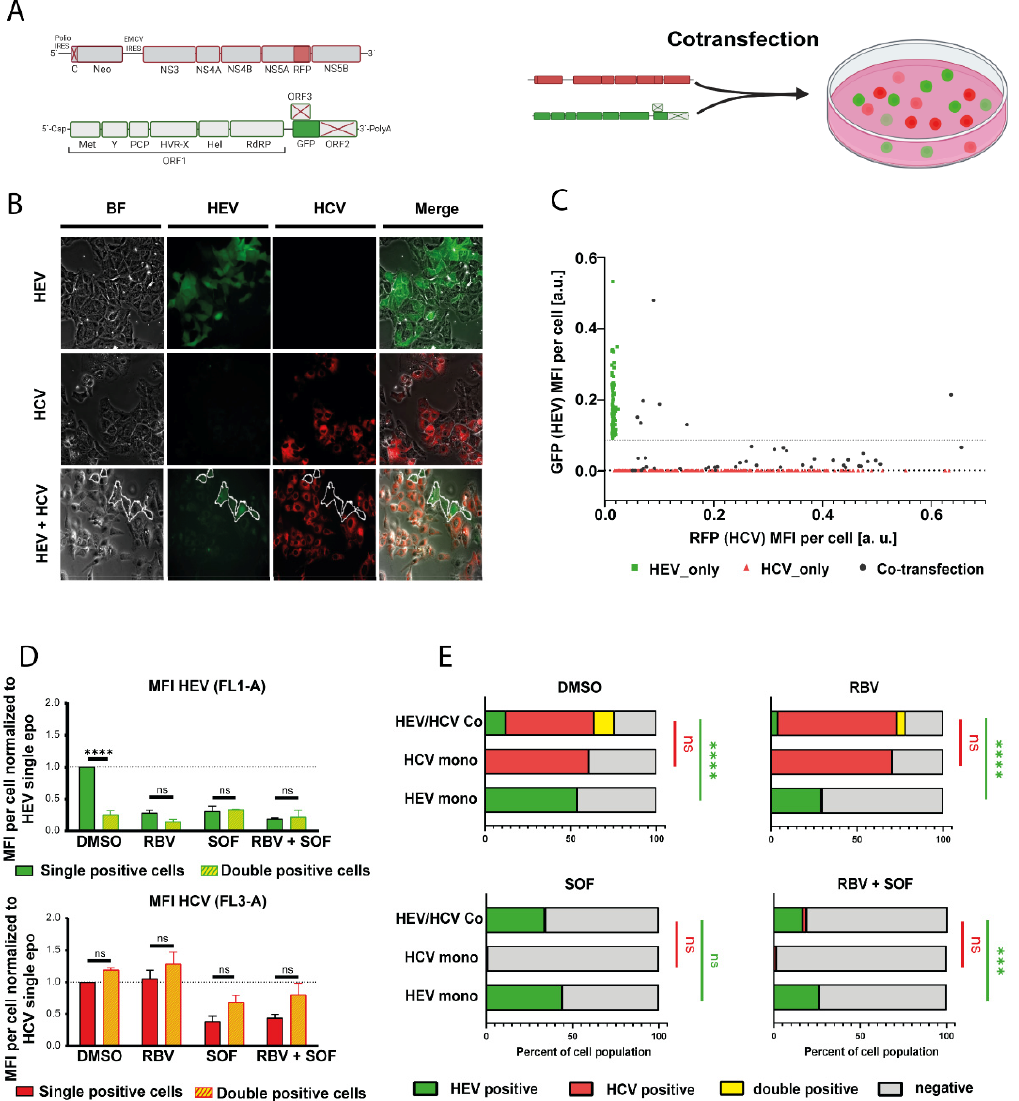
Figure 2. Co-transfection of fluorescently labeled HCV and HEV reporter replicons. ( A ) Scheme of the subgenomic replicon constructs and the experimental design used for experiments. ( B ) Representative IF pictures of Huh7.5 hepatoma cells transfected with the fluorescence reporters HEV p6 GFP and HCV subgenomic replicon JFH1-NS5A-RFP. HEV-positive cells in the HCV/HEV condition are encircled. Cells were imaged 5 days post electroporation ( C ) Plot of GFP mean fluorescence intensity (MFI) vs. RFP MFI of individual cells from 2B. Each point stands for a single cell. ( D ) Co transfected cells were analyzed by flow cytometry 5 days post electroporation. Single and double positive cells were compared for their mean fluorescence intensities of HEV (upper panel) or HCV (lower panel) signal. Cells were incubated with either DMSO or 25 μ M ribavirin (RBV), 10 μ M sofosbuvir (SOF) or 25 μ M ribavirin and 10 μ M sofosbuvir (RBV + SOF). Treatment was started 4 h post electroporation. Depicted are mean ± SD. (Two-way ANOVA with Dunnet’s multiple comparison test). ( E ) Co-transfected cells were analyzed by flow cytometry 5 days post electroporation for the percentage of cells positive for HEV, HCV or both, as determined by flow cytometry. Cells were incubated with either DMSO or 25 μ M RBV, 10 μ M SOF or 25 μ M RBV and 10 μ M SOF. Treatment was started 4 h post electroporation. Depicted are mean ± SD. (Two-way ANOVA with Sidak’s multiple comparison test). *** = p value < 0.001; **** = p value < 0.0001.